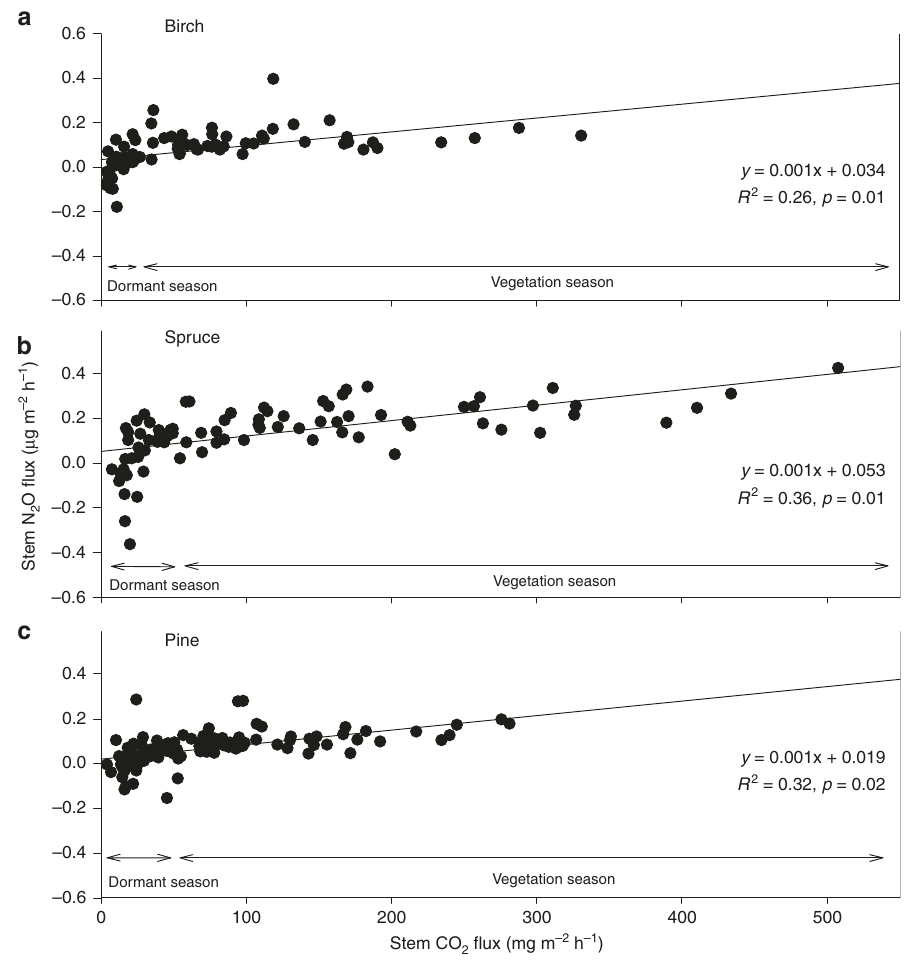
Fig. 3 Relations between N 2 O and CO 2 stem fl uxes. N 2 O versus CO 2 fl uxes in stems of birch ( a ), spruce ( b ), and pine ( c ) measured from June 2014 to May 2015. Data for dormant (October – February) and vegetation (March – September) seasons are indicated. The stem fl uxes were measured from three trees per species at three studied plots characterised by mean annual volumetric water content as wet (0.81 ± 0.02 m 3 m − 3 ; mean ± standard error), moderately wet (0.40 ± 0.02 m 3 m − 3 ), and dry (0.21 ± 0.01 m 3 m − 3 ). The dry plot did not have spruce or birch trees. All fl uxes are expressed per m 2 of stem surface area. Positive fl ux values indicate gas emission, negative values gas